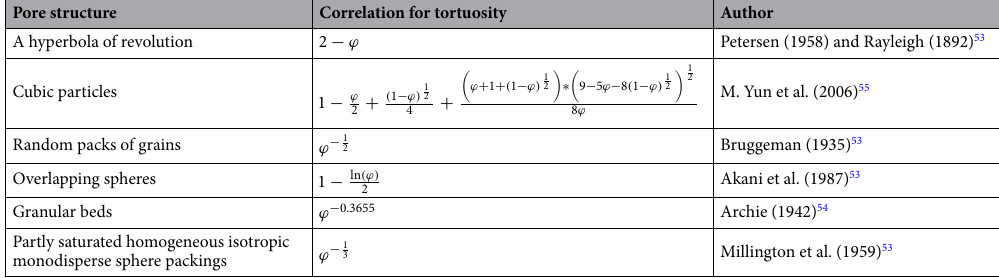
Table 5. Theoretical and empirical tortuosity–porosity relations for porous media obtained from previous studies for different pore